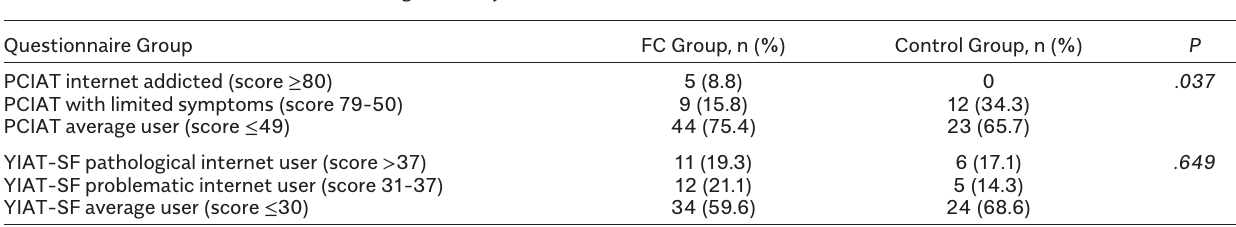
Table 3. Internet Addiction Rates According to Surveys Questionnaire Group FC Group, n (%) Control Group, n (%) PCIAT internet addicted (score ≥ 80) PCIAT with limited symptoms (score 79-50) PCIAT average user (score ≤ 49) YIAT-SF pathological internet user (score > 37) YIAT-SF problematic internet user (score 31-37) FC, functional constipation; PCIAT, Parent–Child Internet Addiction Test; YIAT-SF, Young’s Internet Addiction Test-Short Form. Bold-italic P -value has statistical